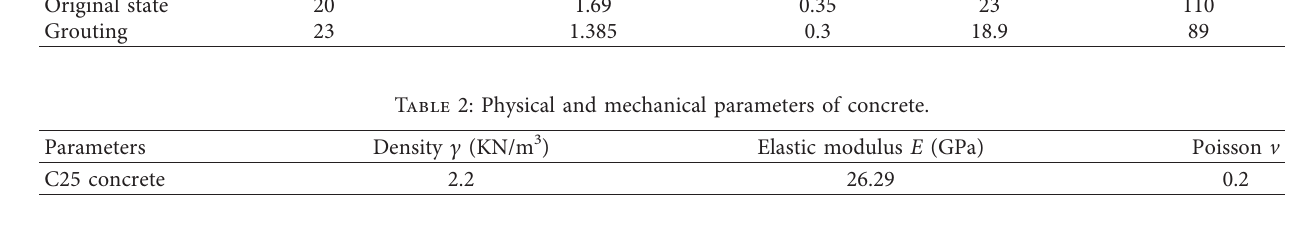
Table 3: Physical and mechanical parameters of